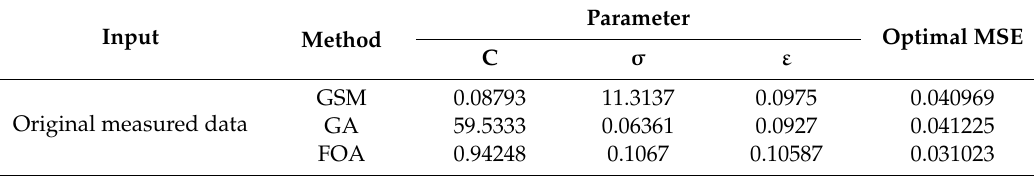
Table 3. Optimal results of the OriginalData-SVR